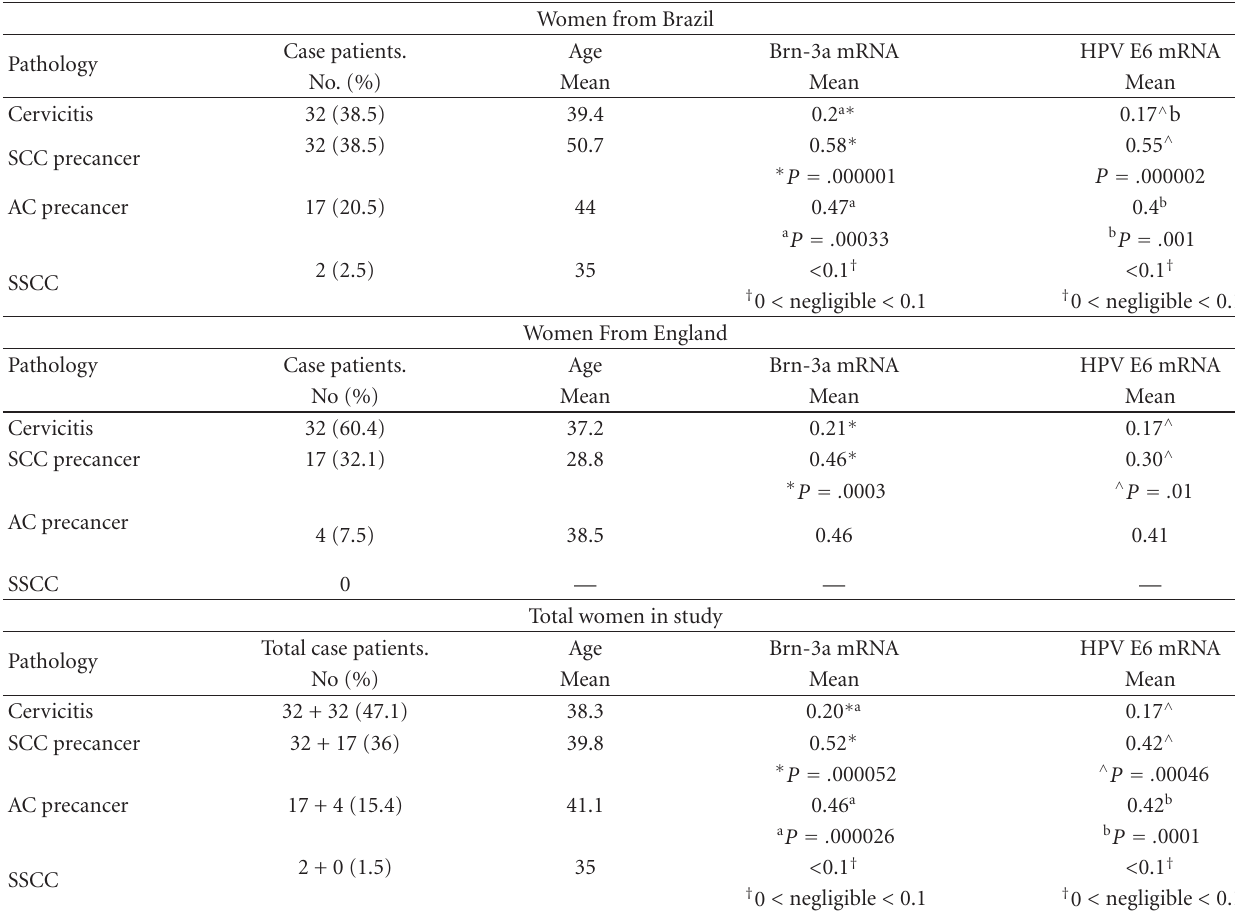
Table 1: Patients in Recife-Brazil and London-UK with rare and common forms of cervical precancer lesions plus a cervicitis control group showing the mean mRNA levels of Brn-3a and HPV E6 in cervical